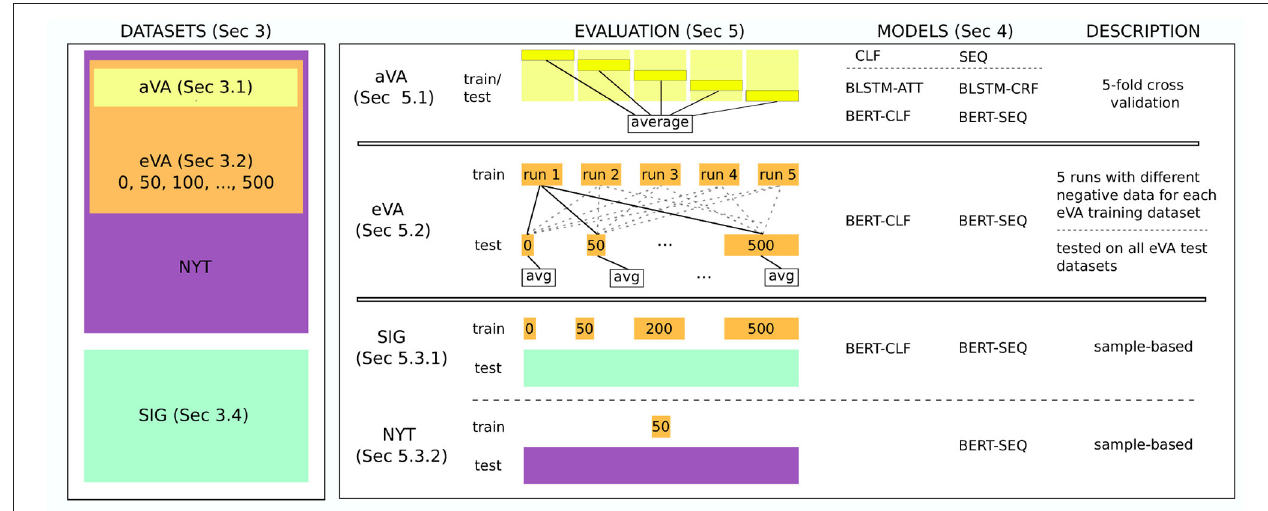
FIGURE 2 | An overview of the models and datasets in the different evaluation setups. On the left side, the datasets are summarized. The aVA dataset is part of the eVA datasets which themselves emerged from the NYT dataset. The SIG dataset on the other hand is independent. On the right side, the evaluation and the models that are evaluated on the corresponding datasets are shown. For example, all models are evaluated on the aVA dataset (top row) whereas only the BERT-SEQ model was used for the robustness study on the NYT dataset (bottom row). The description summarizes how the evaluation has been conducted. All evaluations are conducted independently.